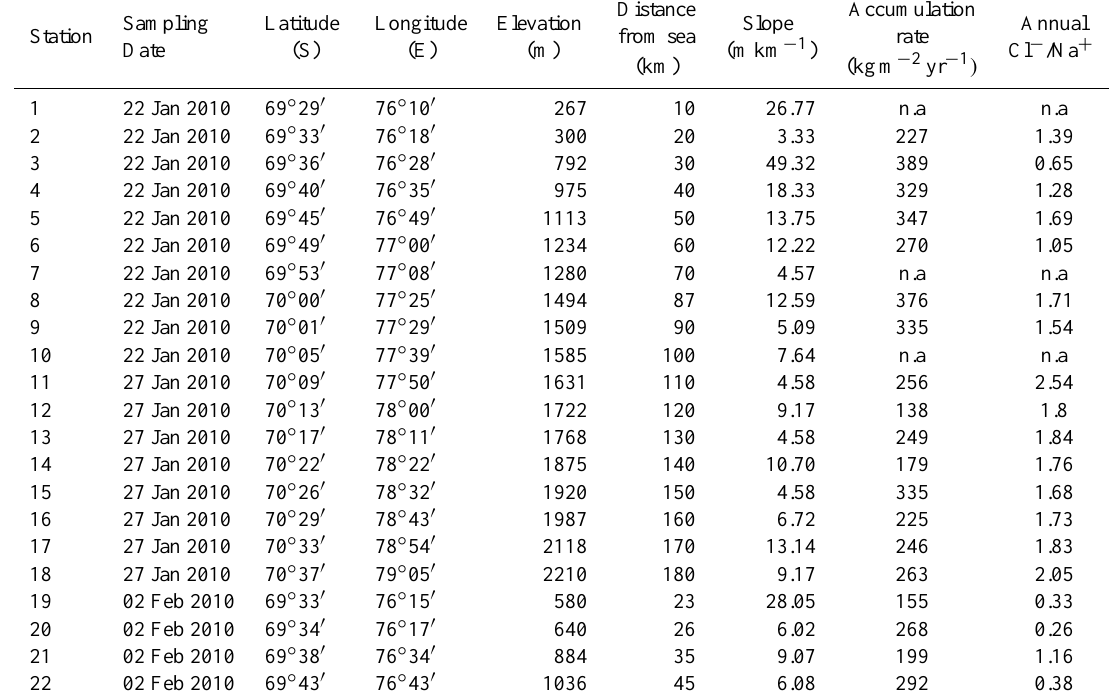
Distance Accumulation Slope